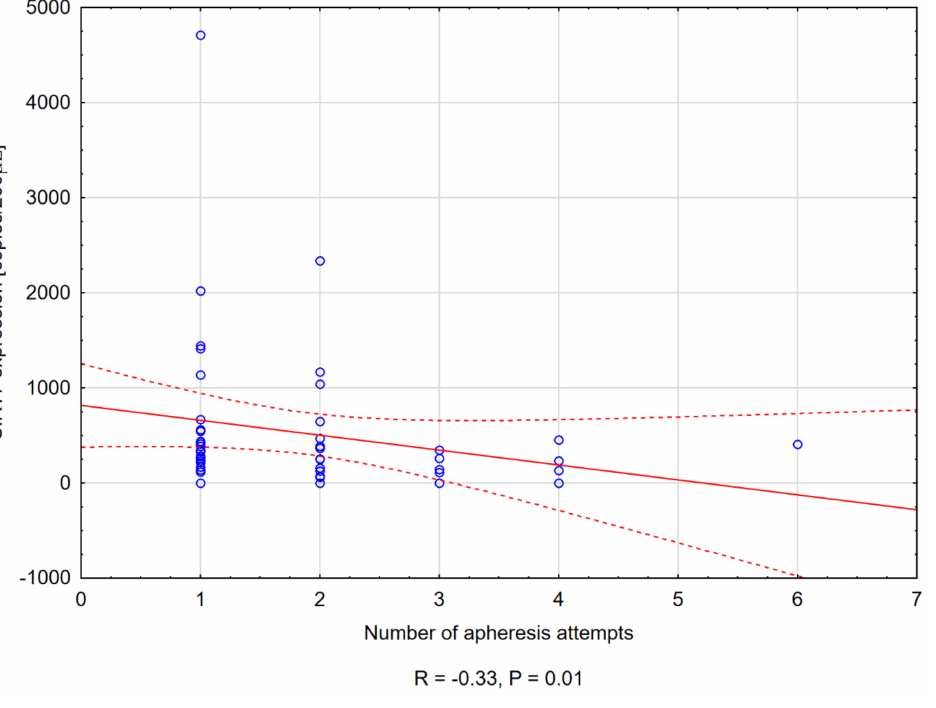
Figure 2. Scatter plot presenting the negative correlation between SIRT7 expression on day A and the number of apheresis attempts needed to collect at least 2 × 10 6 /kg of CD34+